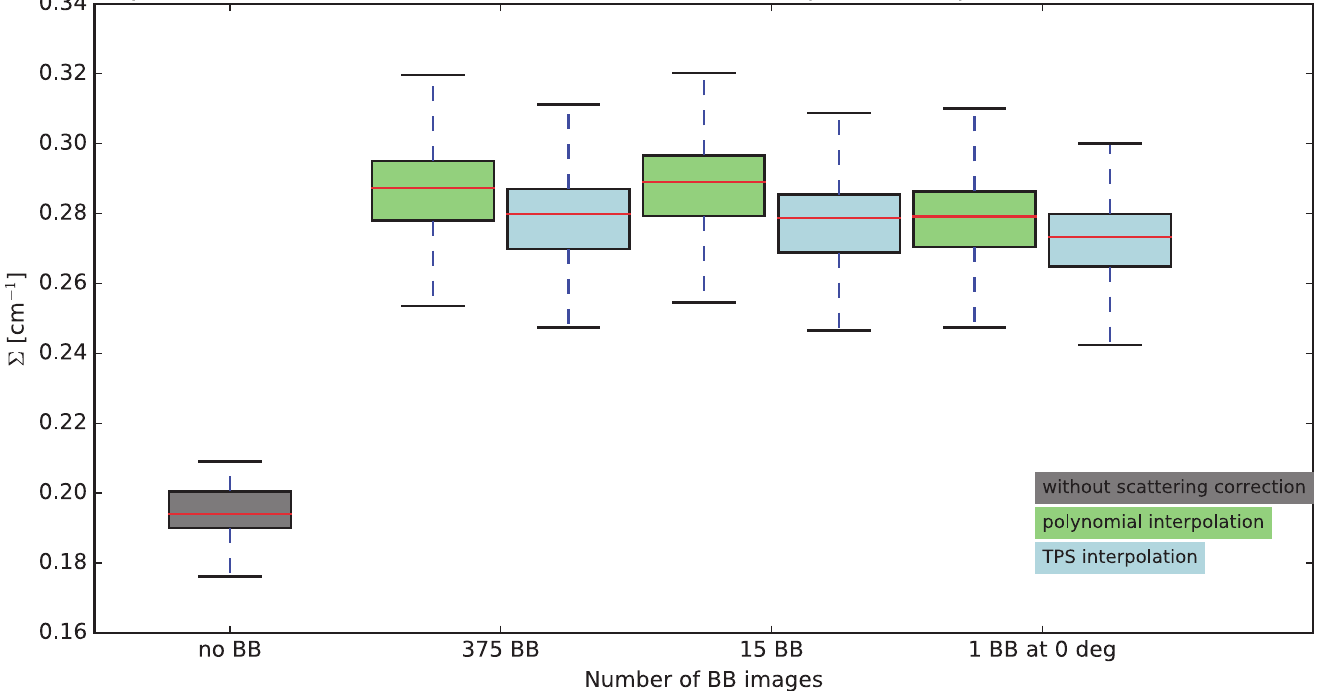
Fig 12. Attenuation coefficients distribution obtained the in plastic ring component of the BNC sample, obtained by varying the number of BB images.